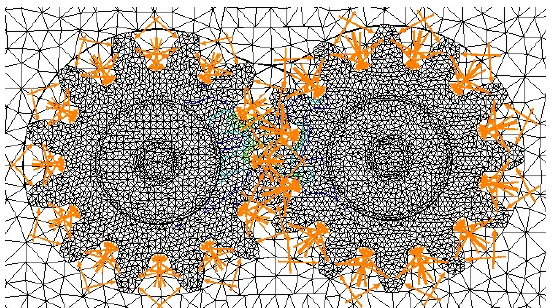
Figure 8. Radial distribution of pressures in the gaps between the teeth .